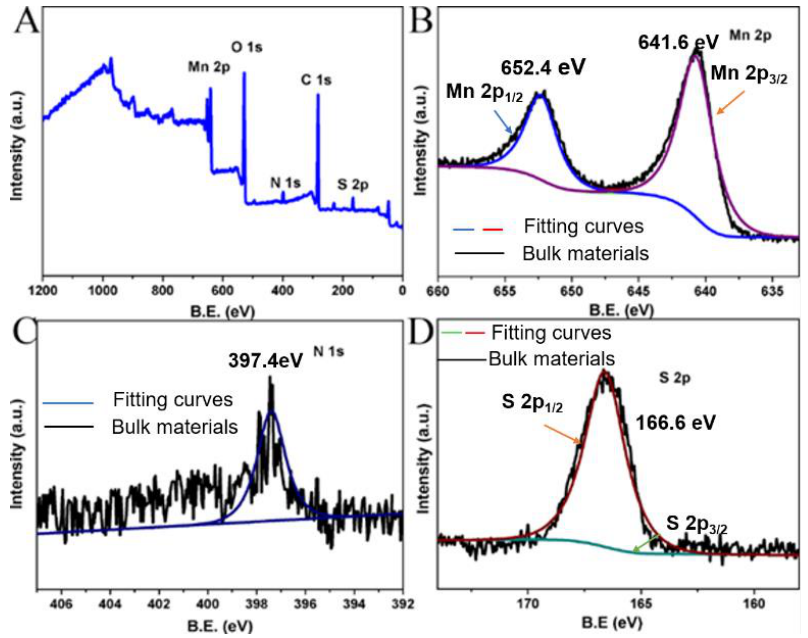
Figure 4. XPS spectra of MnO 2 @PSS/PDDA/PSS: wide scan ( A ), Mn 2p spectra ( B ), N 1s spectra ( C ), S 2p spectra ( D ).